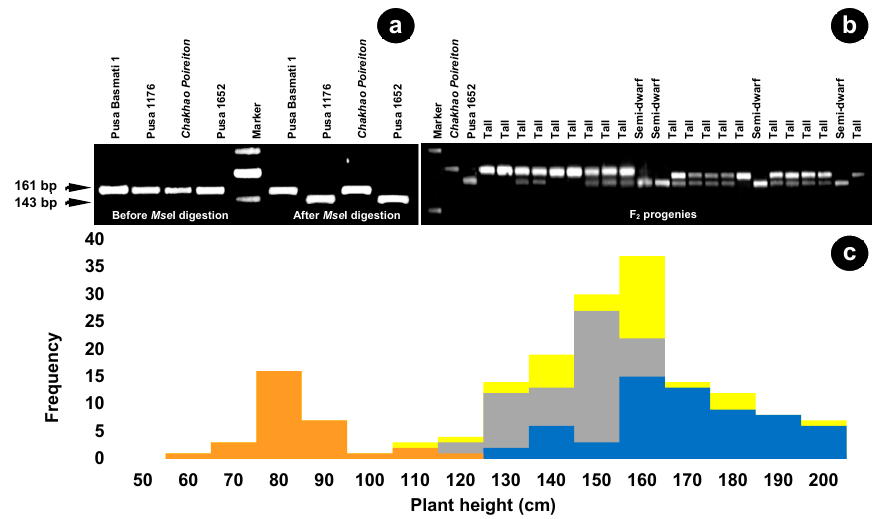
Figure 4. Gel pictogram of the dCAPS marker, AKS-sd1, ( a ) showing the clear differentiation of amplified and cleaved fragments in Pusa 1652 and its parent, Pusa 1176, which carries the novel sd1-bm allele. ( b ) A representative gel image of the parents and the F 2 segregants showing the differentiation of height classes. ( c ) Frequency distribution of plant height among the different allelic classes of AKS-sd1, perfectly matched to the bimodal distribution. Segregants carrying the Pusa 1652 allele ( sd1-bm ) are shown in orange, and those with the Chakhao Poireiton allele ( SD1 ) are shown as blue bars. The heterozygotes are shown as grey bars. The yellow bars indicate the overall frequency distribution of F 2